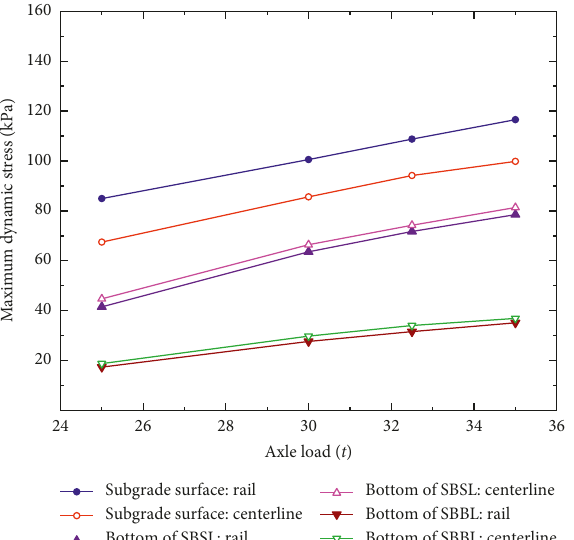
Figure 14: Relationship between the maximum dynamic stress and depth from the subgrade